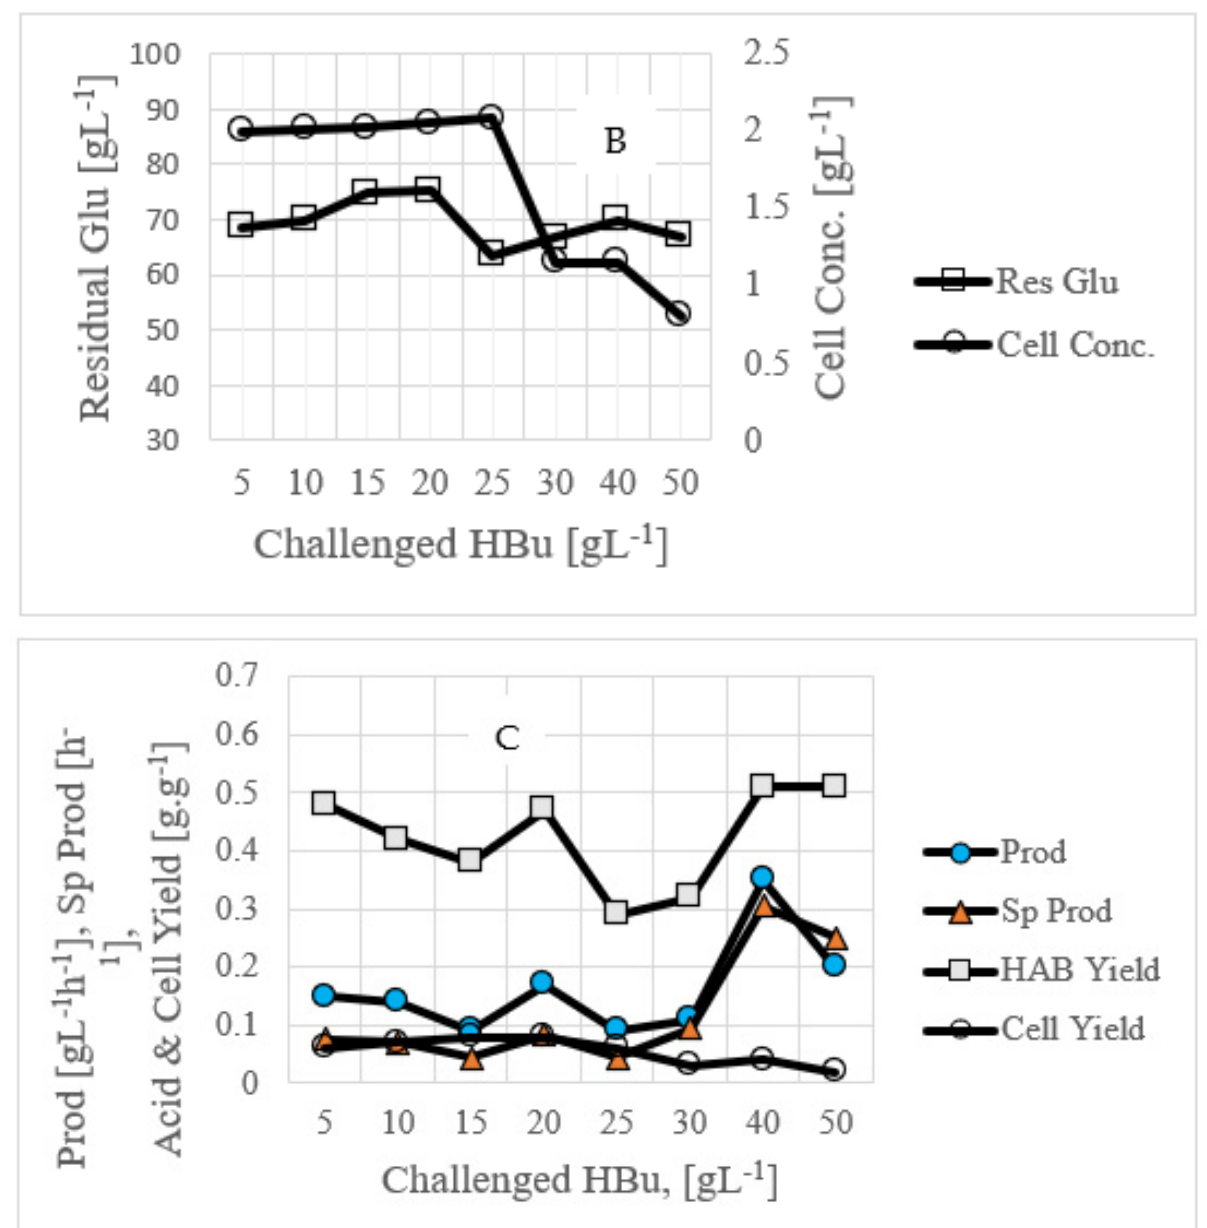
Figure 2. Butyric acid inhibition on C. tyrobutyricum . ( A ) Production of acids at various added butyric acid concentrations; ( B ) residual glucose and cell concentration; ( C ) productivities, specific productivities, acid yield, and cell yield.